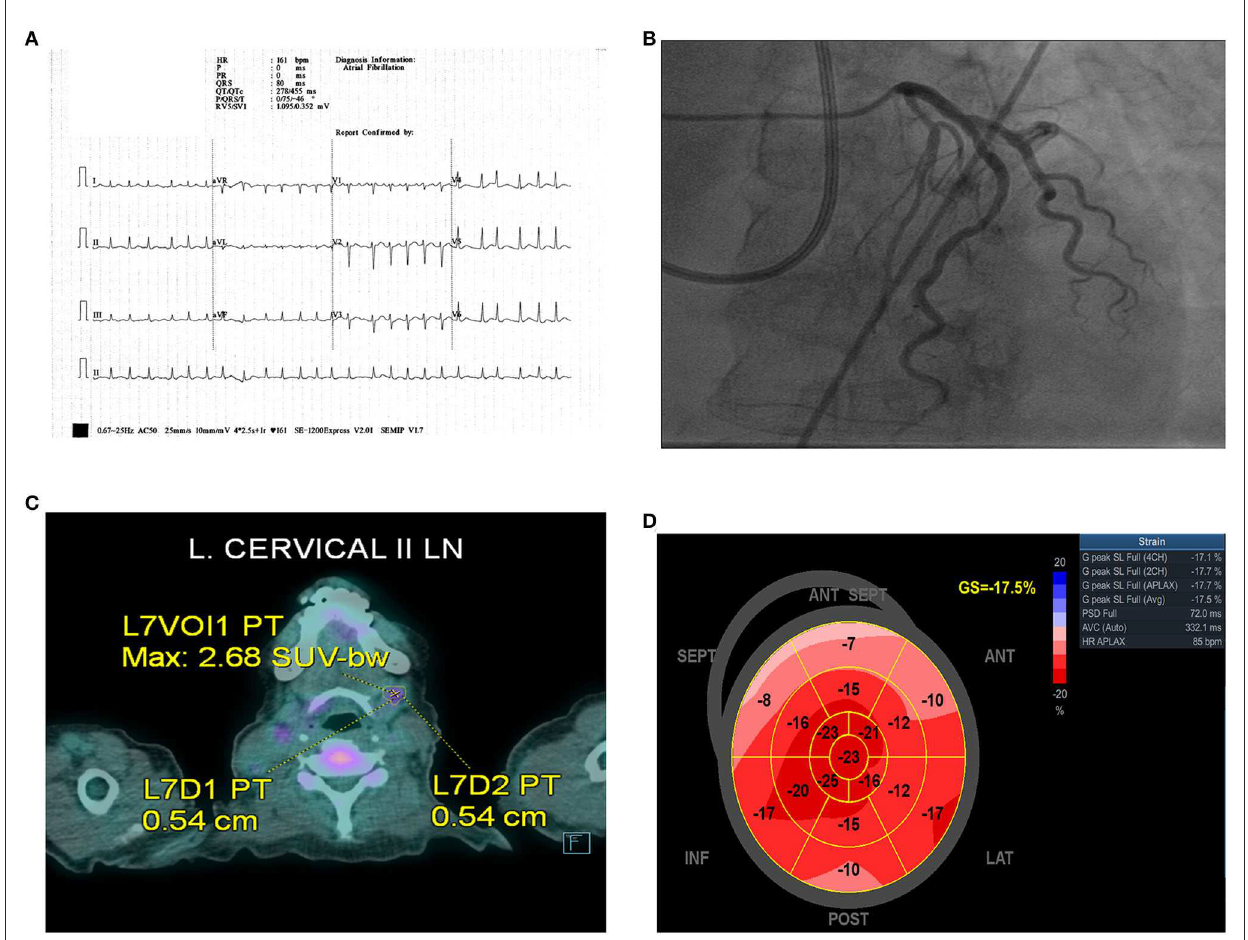
FIGURE1 Key investigations performed. (A) Electrocardiogram showing atrial fibrillation with rapid ventricular response. There was no significant ST segment or T wave change. (B) Coronary angiogram showed no obstructive coronar artery disease. (C) Positron emission tomography and computed tomography (PET-CT) showed lymphadenopathy over cervical, bilateral axillary, mediastinal, hilar, porta hepatis, and peripancreatic areas. (D) Cardiac strain analysis performed prior to discharge from hospital showed nearly normalized LVEF of 57.5% and global longitudinal strain (GL) of − 17.5%. Decreased segmental longitudinal strain in anterior, anteroseptal, inferoseptal, and posterior from basal to mid level, and decrease in layer-specific strain from epicardial to mid-myocardial were observed.